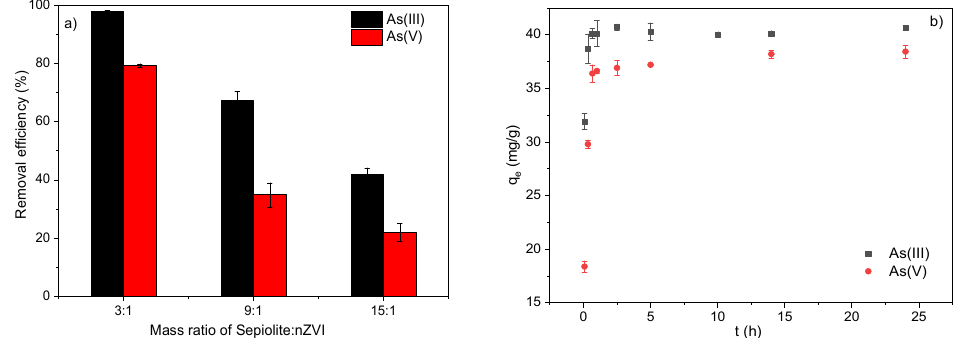
Figure 1. ( a ) Comparison of the As(III)/As(V) adsorption capacity of S-nZVI prepared with different sepiolite:nZVI mass ratios; ( b ) adsorption kinetic curves of As(III) and As(V) by S-nZVI.